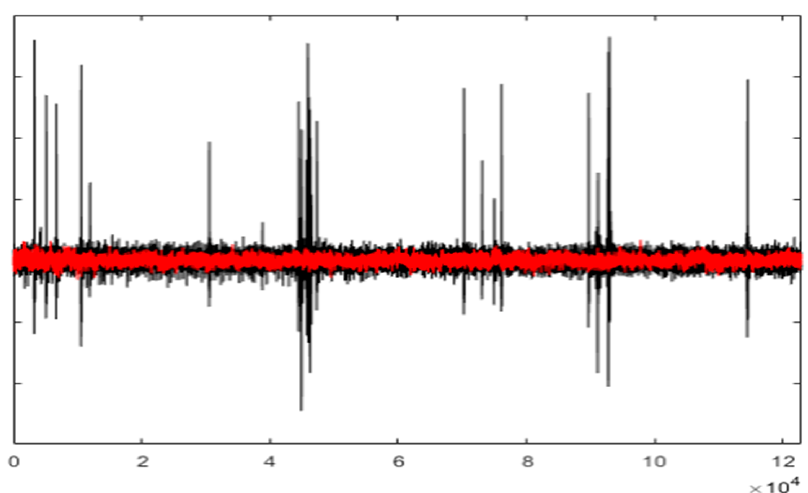
Figure 14. The AF8 channel of AEEG with (in black) and without artefacts (in red) after using wICA. The X axis shows the samples.